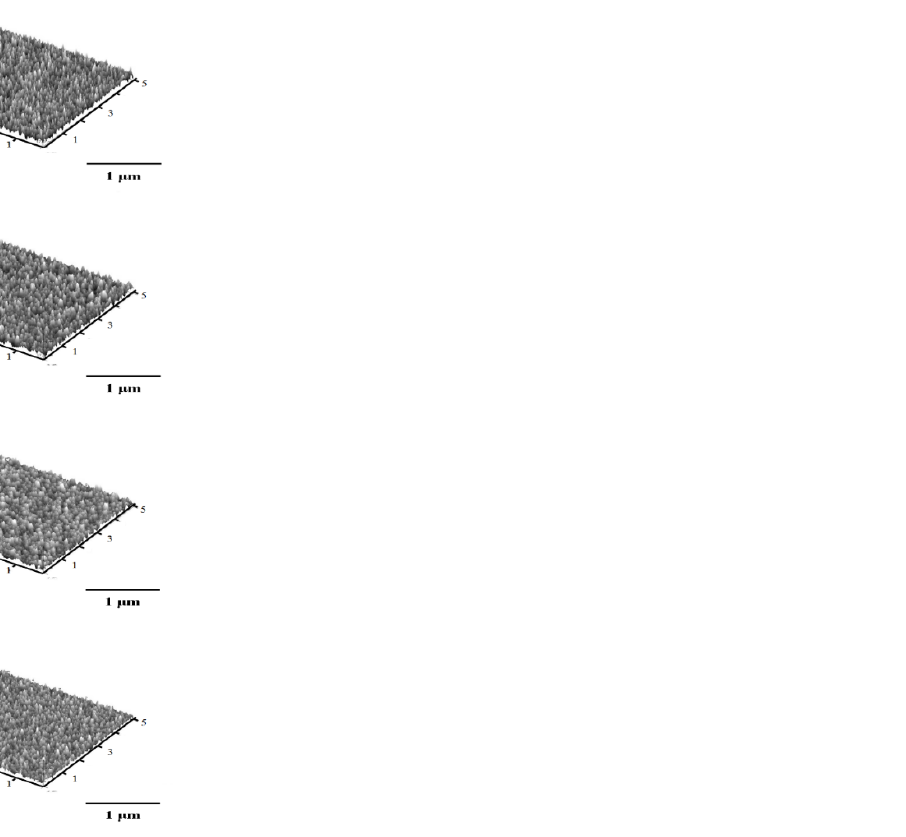
Figure 4. AFM surface morphologies of MoN coatings deposited using ICP assisted sputtering with various ICP powers.